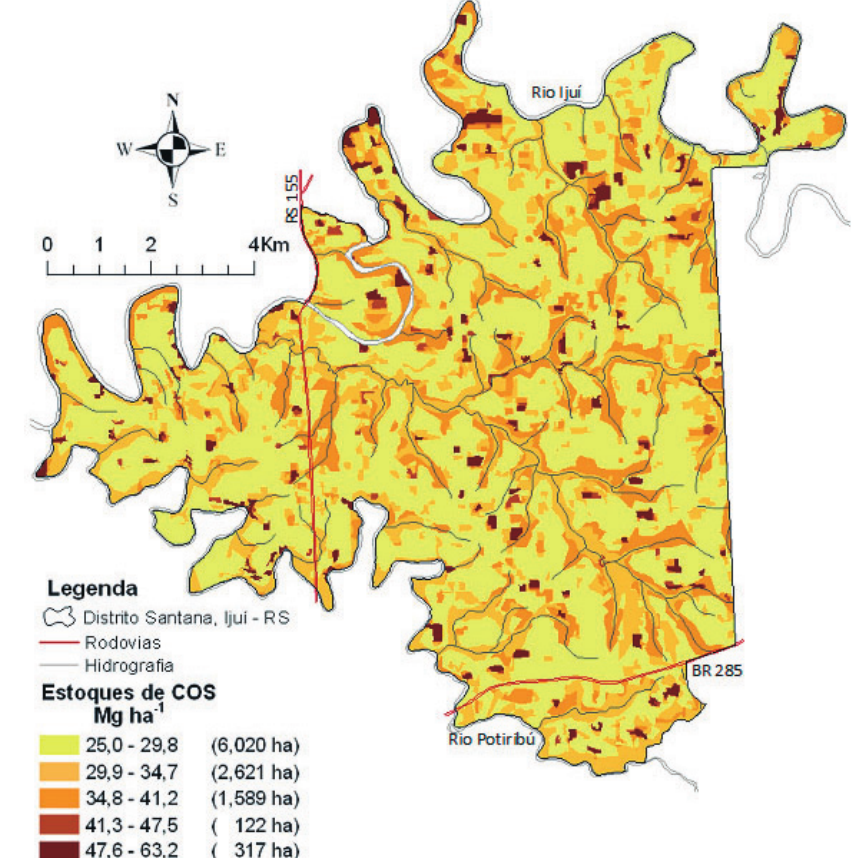
Figura 6. distribuição espacial dos estoques de carbono orgânico do solo (cos), em 2007, nos solos do distrito santana, ijuí-rs, estimados pelo modelo century, considerando diferentes épocas de início do uso agrícola, cenários de manejos do solo e posição na paisagem. estoques de cos nas lavouras em massa equivalente à camada de 0 a 20 cm da mata